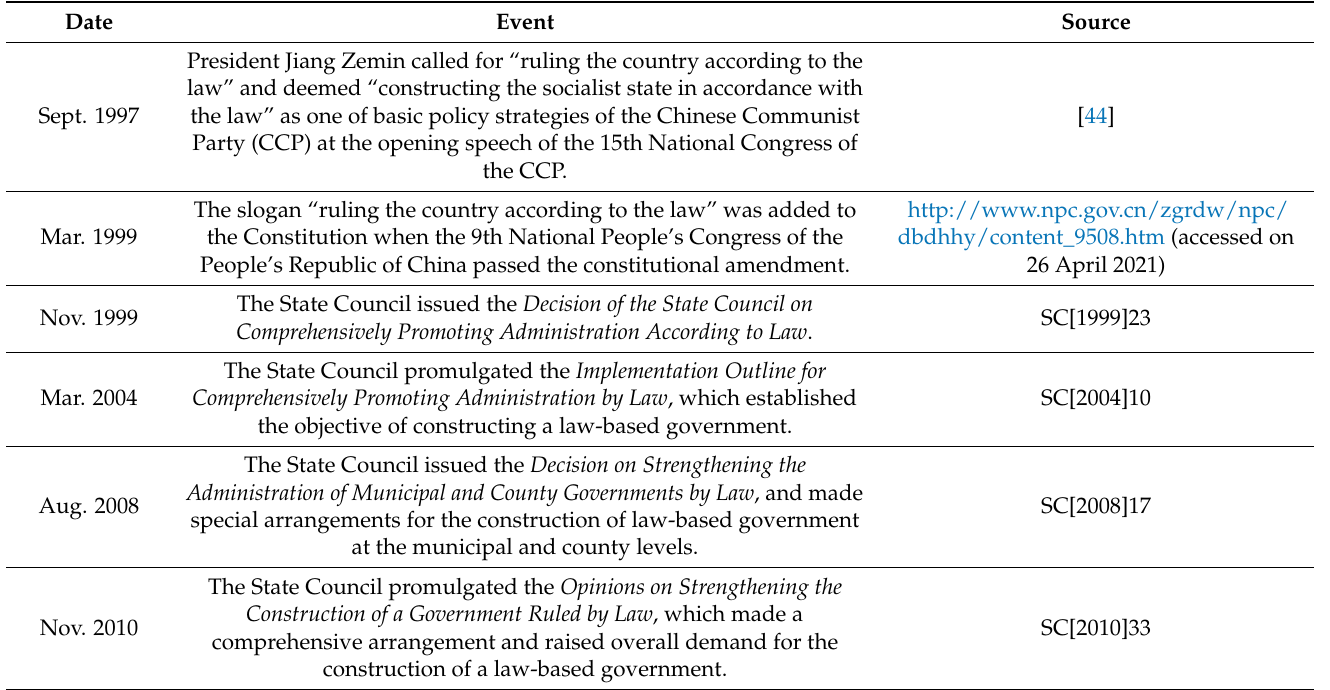
Table 1. Major events in China’s pursuit of law-based